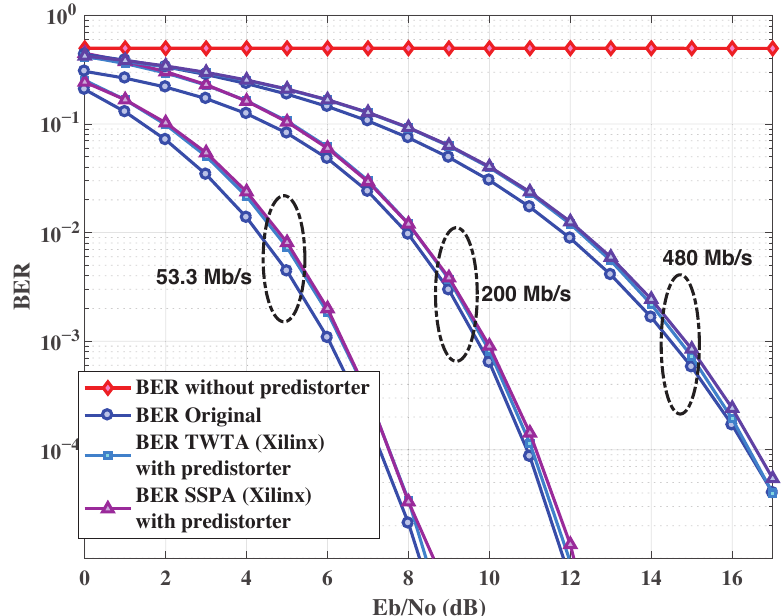
Figure 14. Bit Error Rate without and with NN pre-distorter for